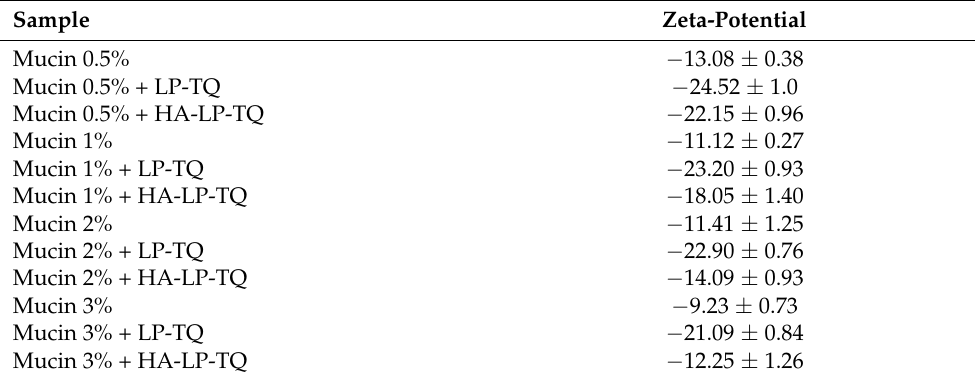
Table 2. Zeta-potential (mV) of different solutions of mucin and mixtures with LP-TQ or LP-TQ-HA. Sample